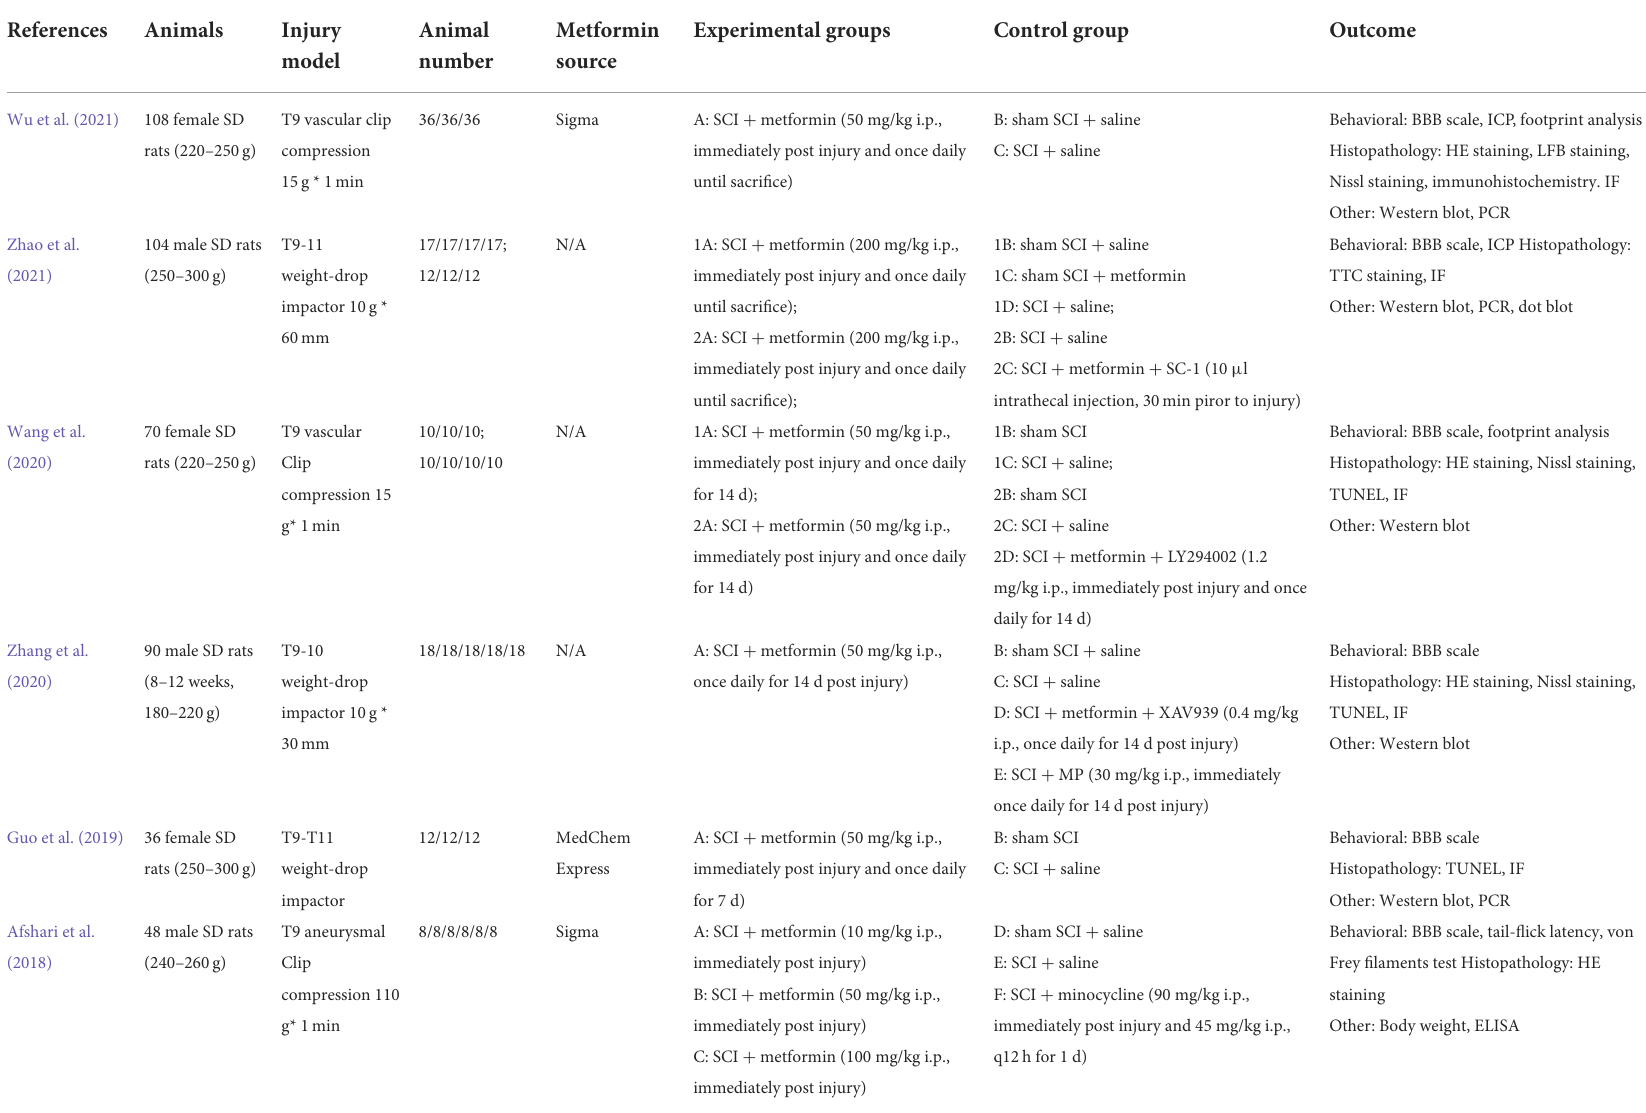
TABLE 1 Characteristics of studies included in the